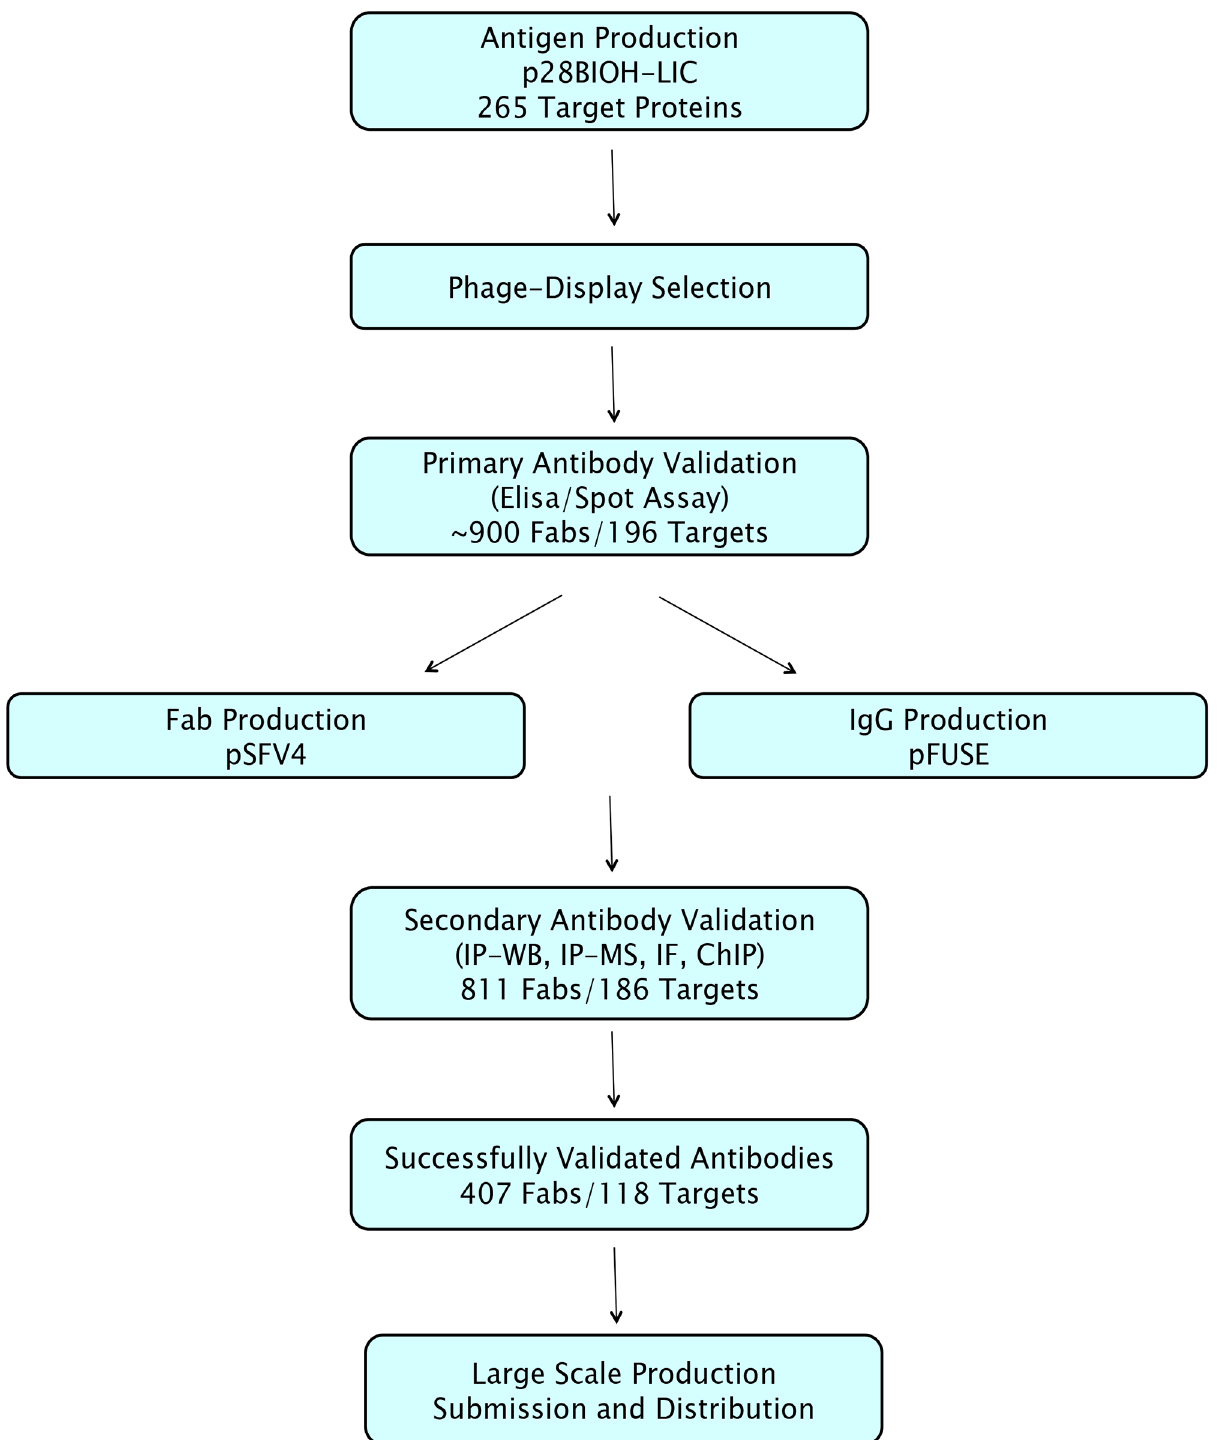
Fig 4. Pipeline overview. Overview of the project pipeline from antigen production to cell-based validation, either on Fabs or IgGs.